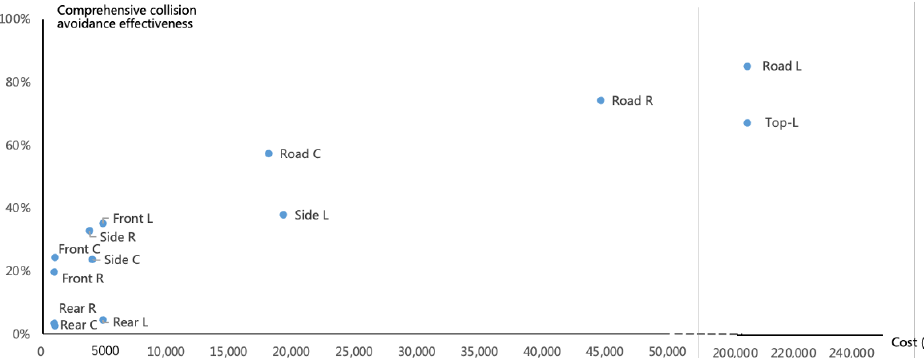
Figure 3. Comprehensive collision avoidance effectiveness and cost of different “atomic” technolo- gies.